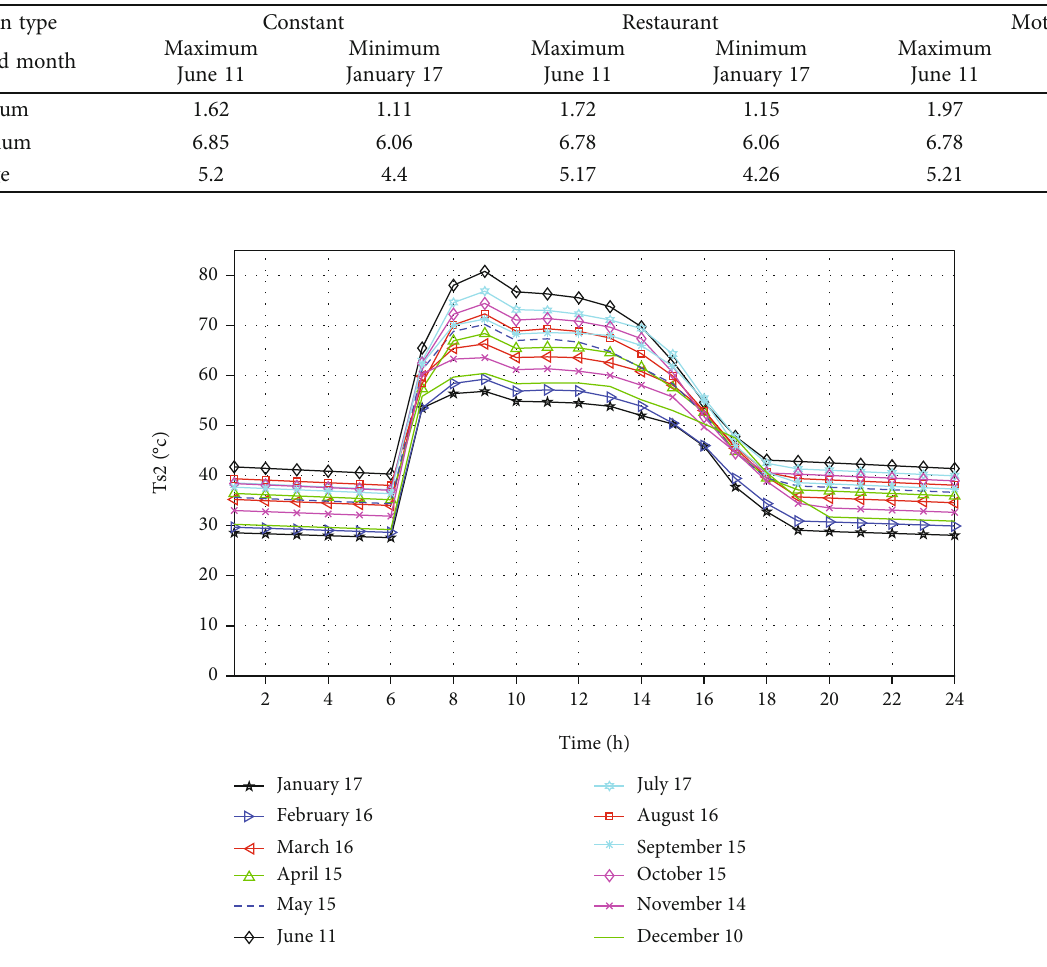
Figure 7: Storage water temperature in the case of constant consumption